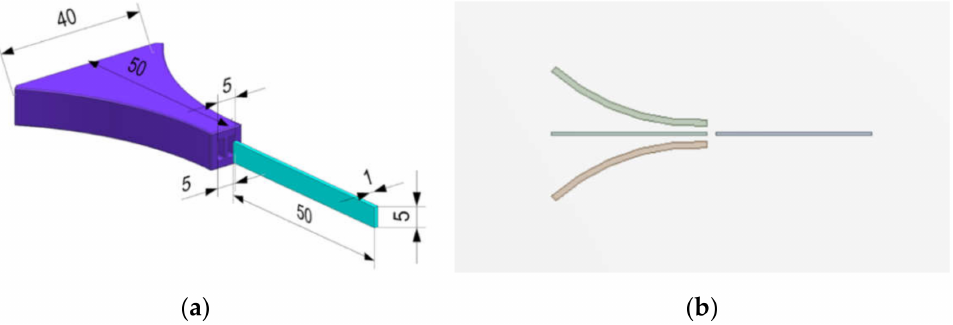
Figure 1. Modeling of the FTEH: ( a ) 3D CAD Model; ( b ) 2.5D